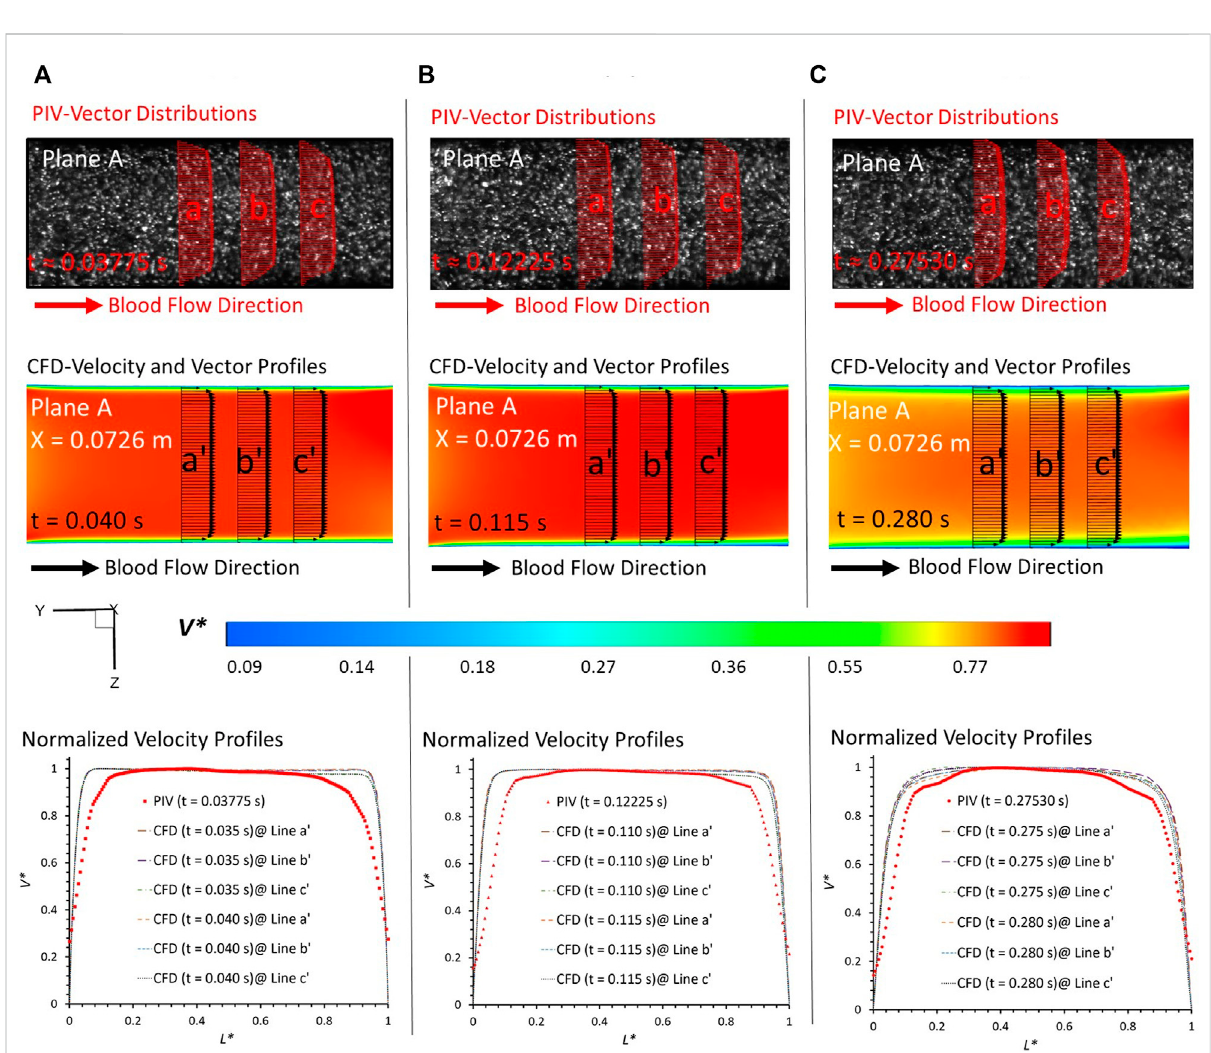
FIGURE 5 Comparisons at plane A at X = 0.0726 m (according to thecoordinates in CFD) between PIV measurements and CFD simulations at designated time instants: (A) t = 0.03775 s, (B) t = 0.11225 s, and (C) t = 0.27530 s.